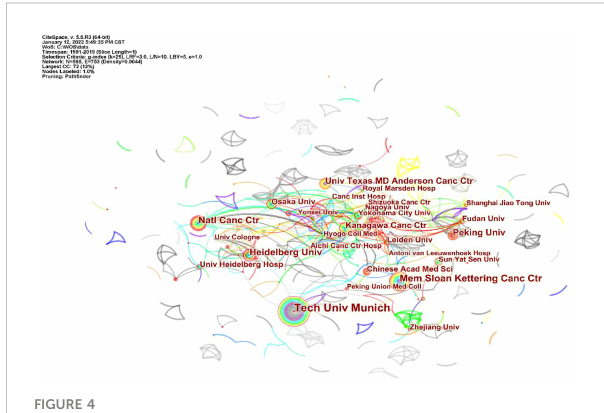
FIGURE 4 Distribution of literature sources related to neoadjuvant chemotherapy for GC from 1991 to 2021 based on institutions.